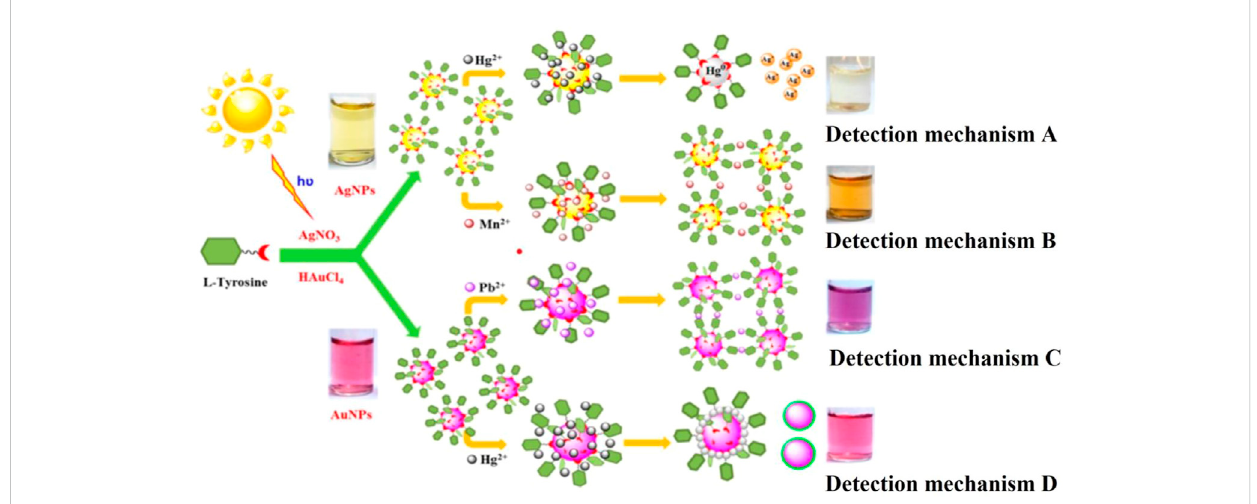
FIGURE 7 Schematic illustration of sunlight assisted L-tyrosine synthesized AgNPs and AuNPs for multiple metal ions detection. Reproduced with permission (Annadhasan et al., 2014). Copyright 2014, American Chemical